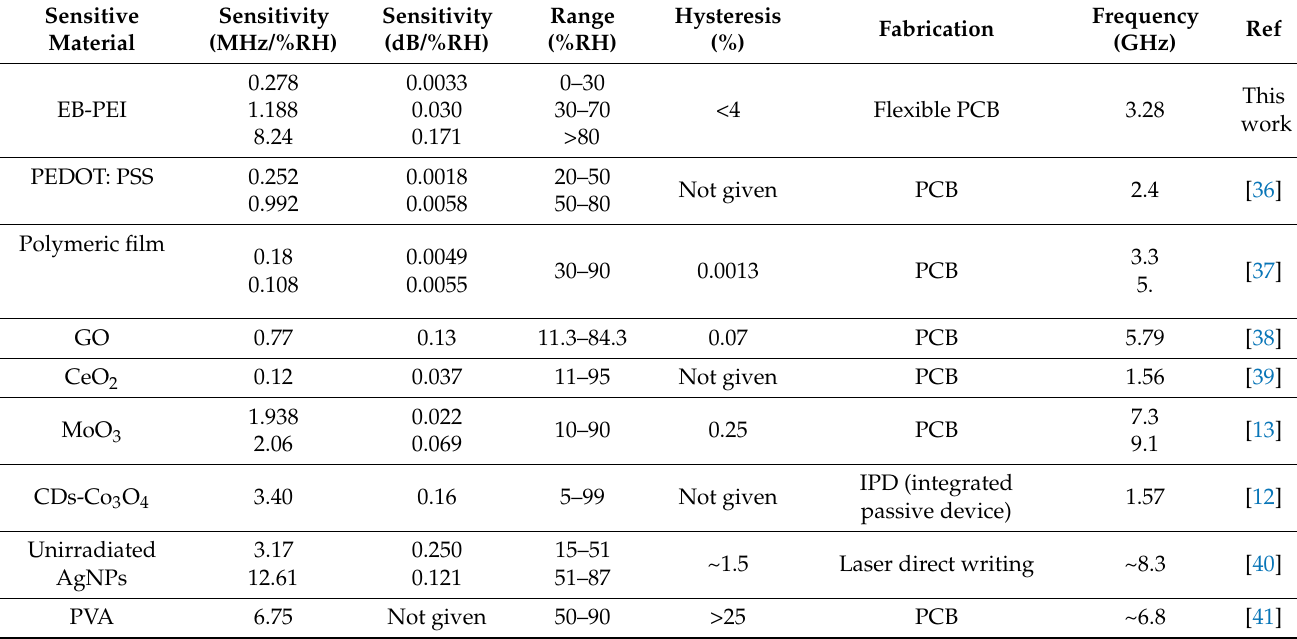
Table 1. Comparison of microwave humidity sensors based on different sensitive materials.